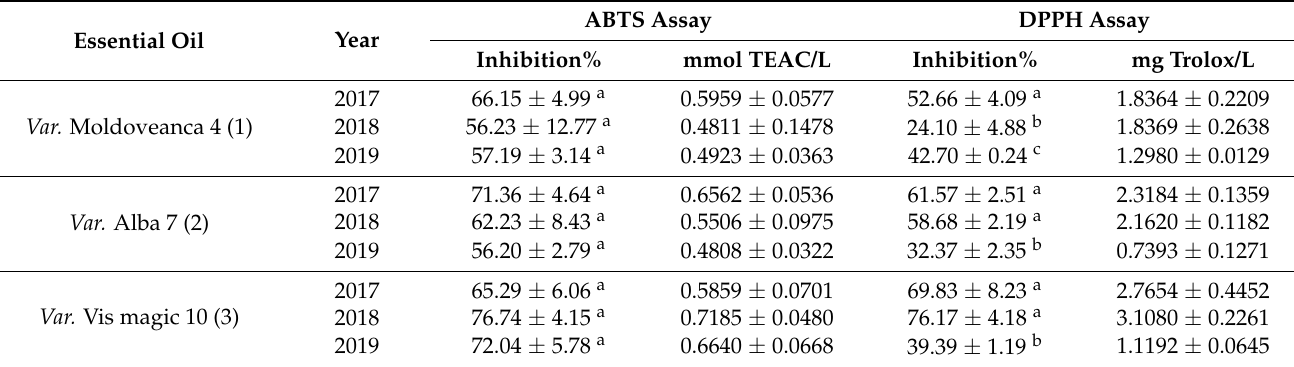
Table 3. The antioxidant activity determined by ABTS and DPPH assays for the essential oils obtained in 3 years (2017–2019) for Lavandula angustifolia (Moldoveanca 4, Alba 7, and Vis magic 10), where p < 0.05. Essential Oil